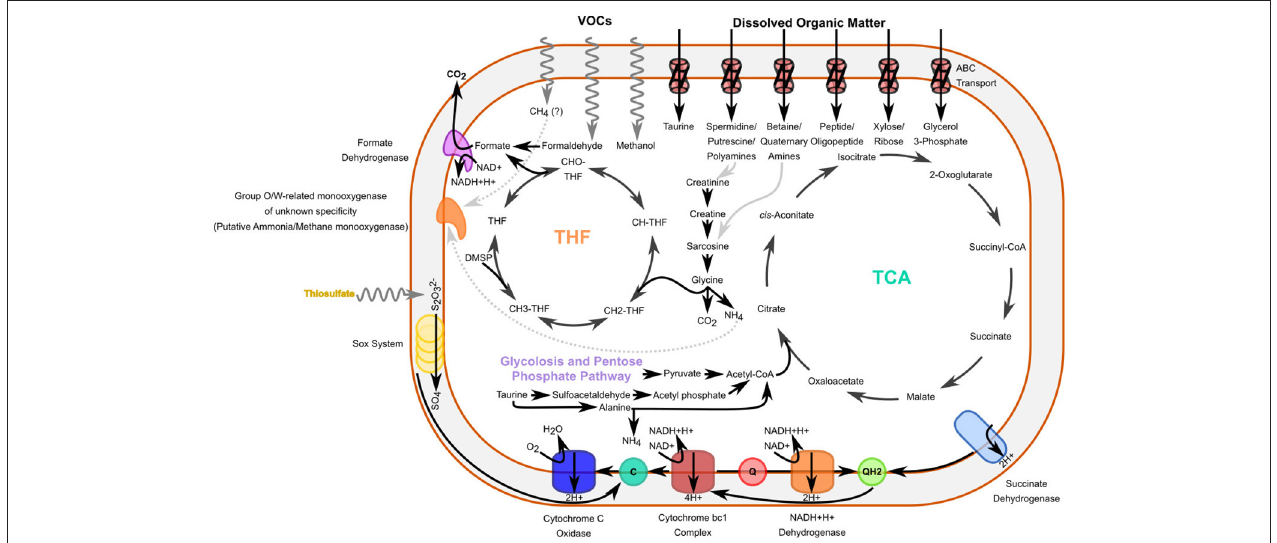
FIGURE 7 | Cell diagram outlining some of the probable metabolic features of a E01-9C-26 Gammaproteobacterial cells. These cells appear to have the ability to degrade or assimilate a methylated compounds, as well as amines, and may additionally have the ability to oxidize reduced sulfur, as well as use organosulfur compounds for energy or growth. THF: Tetrahydrofolate-mediated oxidation/assimilation pathway for methylated compounds. TCA: Tricarboxylic Acid cycle. Gray pathways indicate plausible sources of some specific